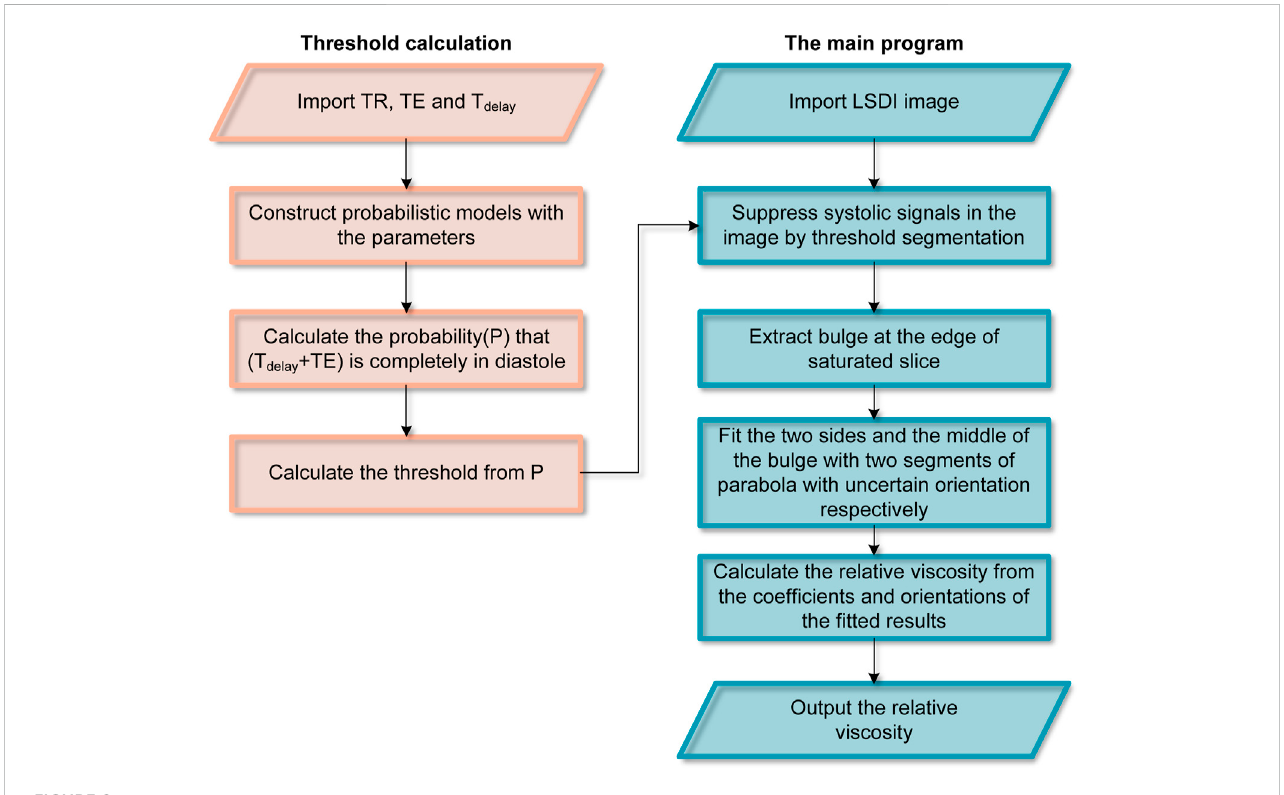
FIGURE 2 Work fl ow for extracting WBRV from LSDI